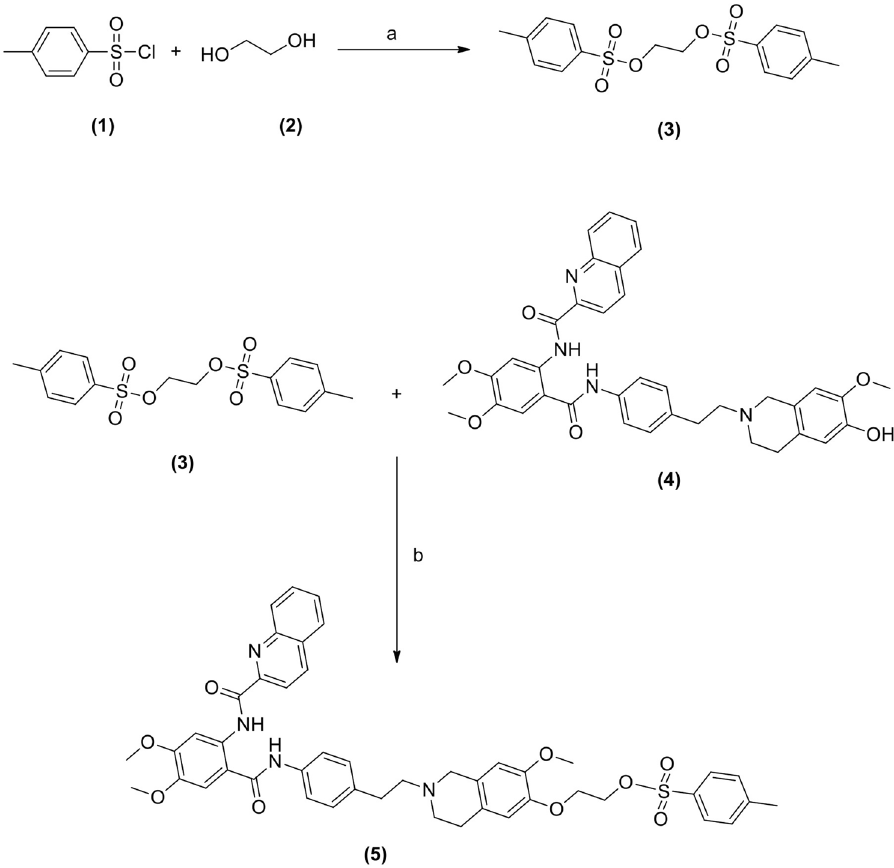
Figure 1. Reaction and reagents for the synthesis of the tosylate precursor 5 : ( a ) Pyridine, 0–5 °C, stirring, 3 h ( b ) acetone, Cs 2 CO 3, stirring at room temperature followed by heating and stirring at 50 °C for 6